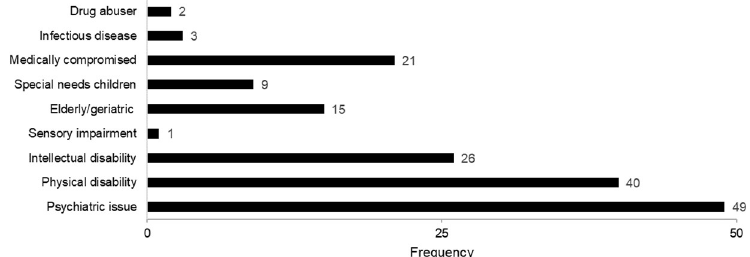
Fig 1. Frequency of SCD patients. Respondent who wrote at least one group of SCD patient was considered to have good perception of SCD. Each mention of SCD patient group was counted as one.